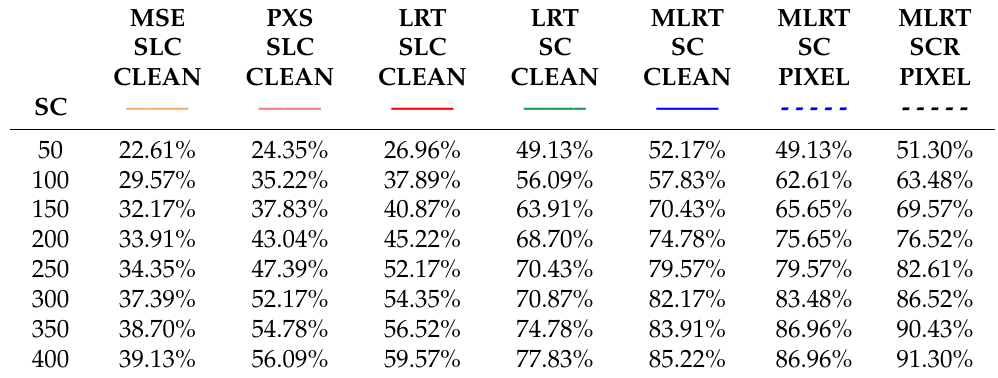
Table 4. Standard Operating Condition—Percentage of Correct Classification for different implemen- tations resulting from 10-class within class classification tests.